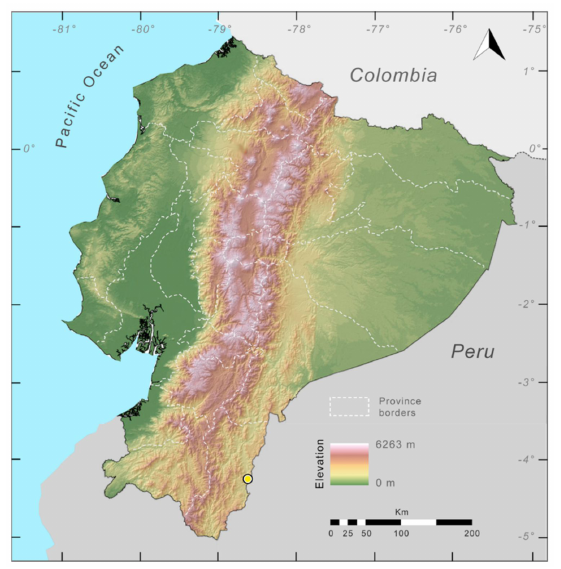
Figure 166. Distribution of Nymphargus lindae sp. nov. in Ecuador (yellow